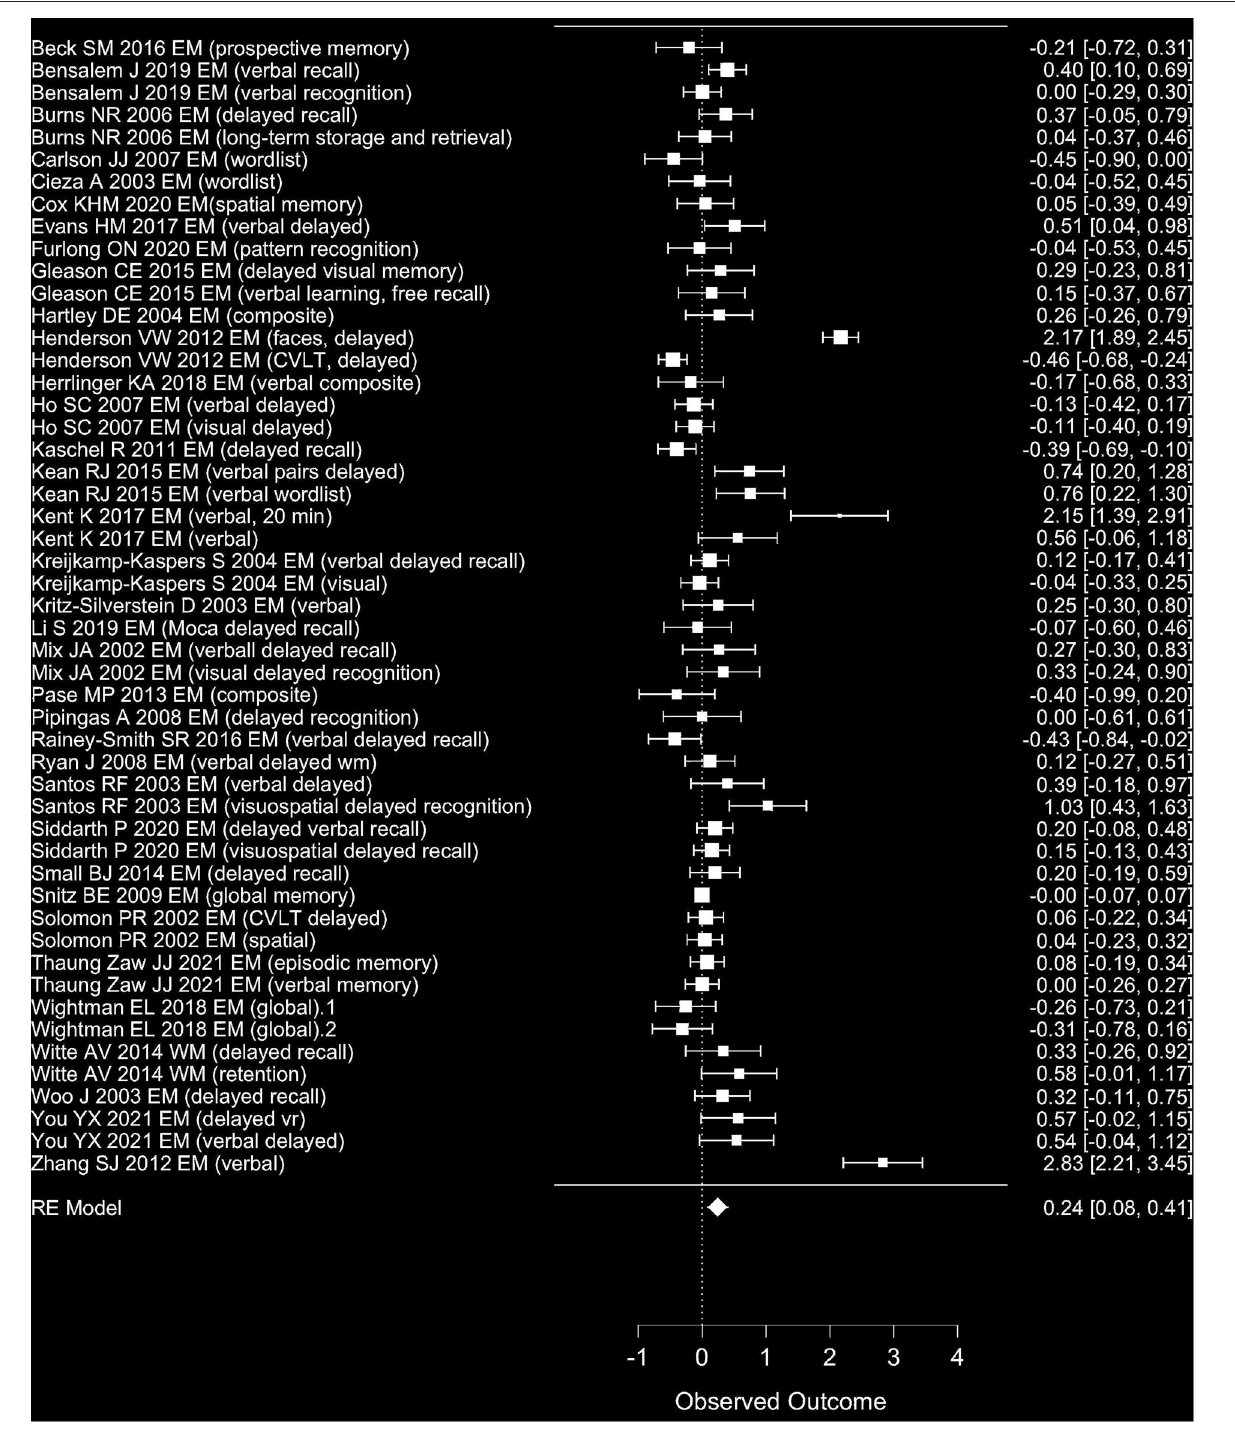
Frontiers in Nutrition |